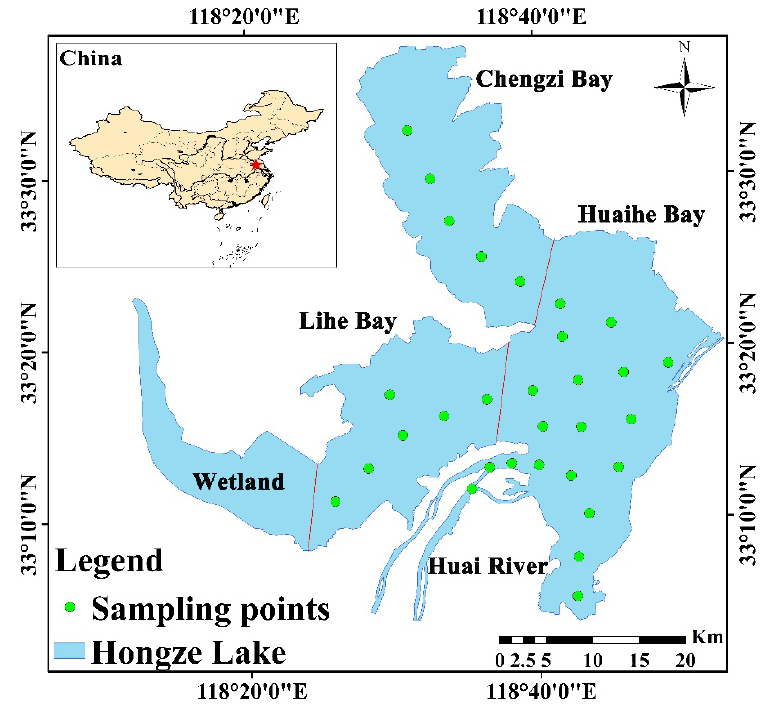
Figure 1. The study area and the distribution of sampling